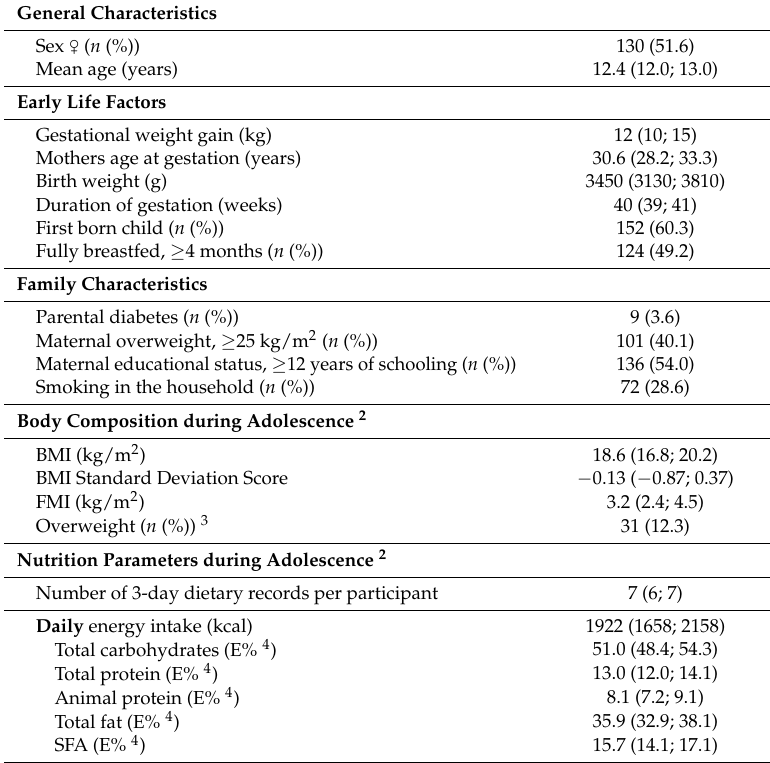
Table 1. Baseline sample characteristics 1 ( N =